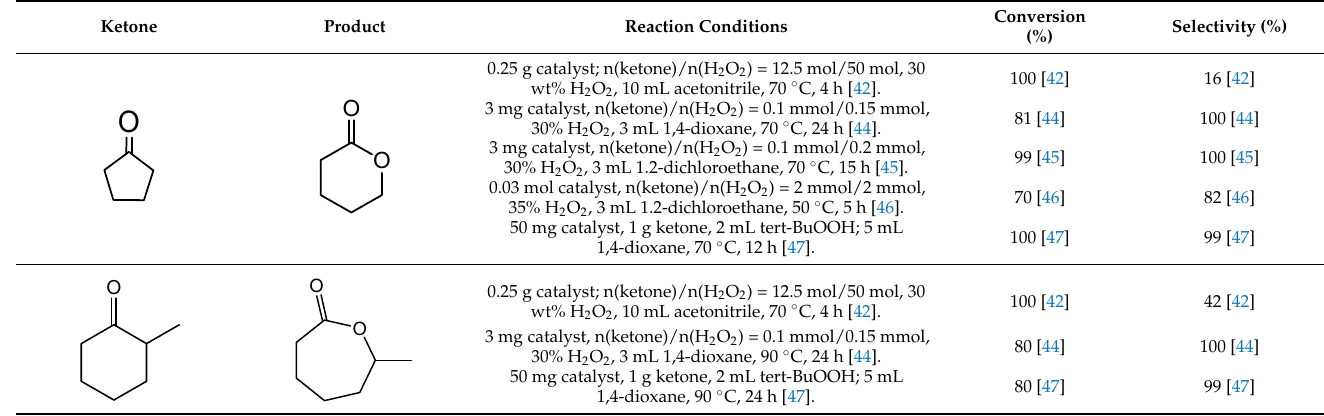
Figure 5. Interaction between Re and hydrogen peroxide [50]. Table 4. Catalytic performances of Sn-containing materials for the oxidation of cycloketones.